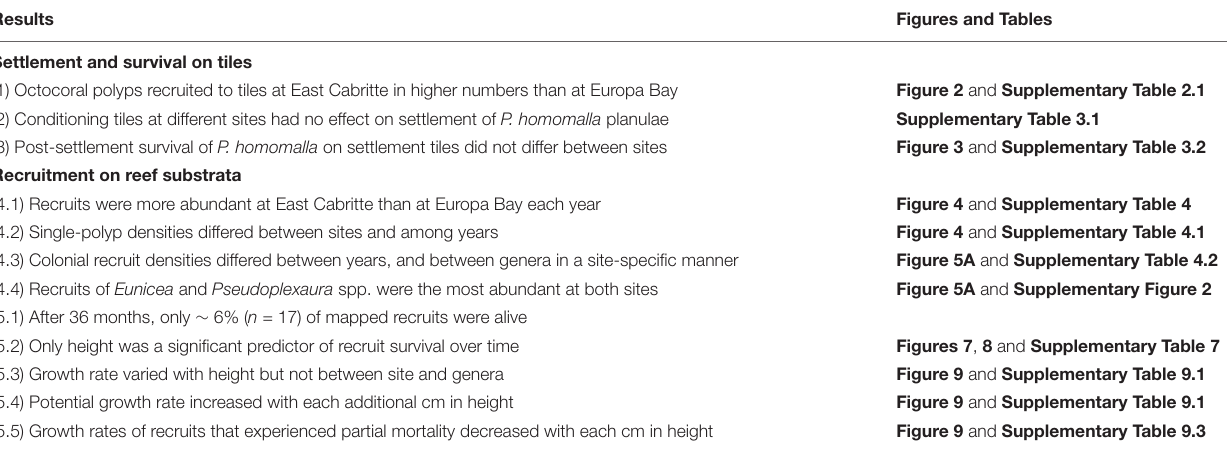
TABLE 1 | Summary of study results and corresponding figures and tables.